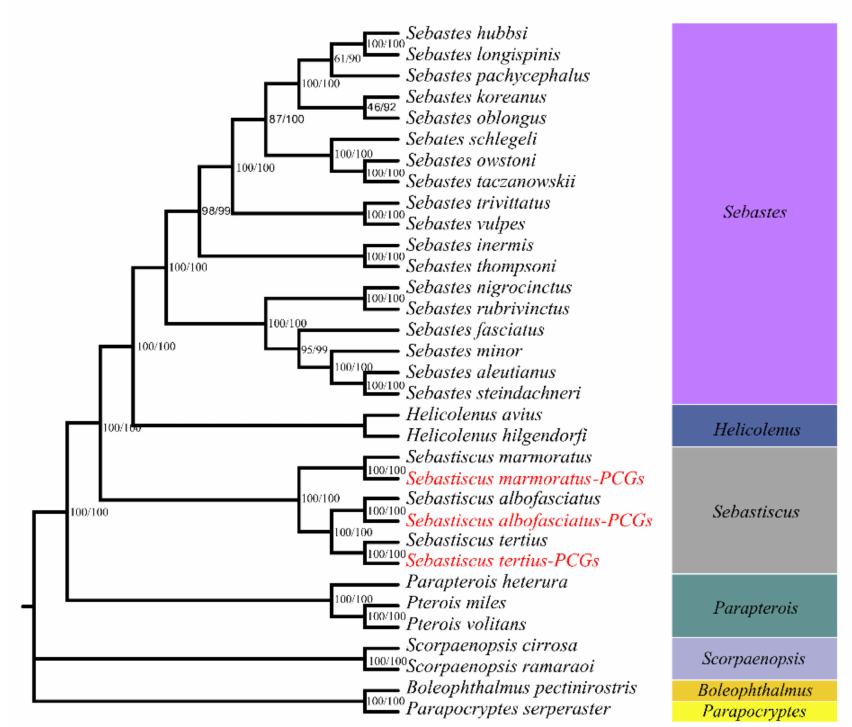
Figure 7. Phylogenetic tree of 25 Scorpaenidae sequences constructed by neighbor-joining (NJ) and maximum likelihood (ML) methods based on concatenated sequences of 13 PCGs. Boleophthalmus pectinirostris and Parapocryptes serperaster were used as the outgroup. The species in red Latin name indicates the sequences generated in this